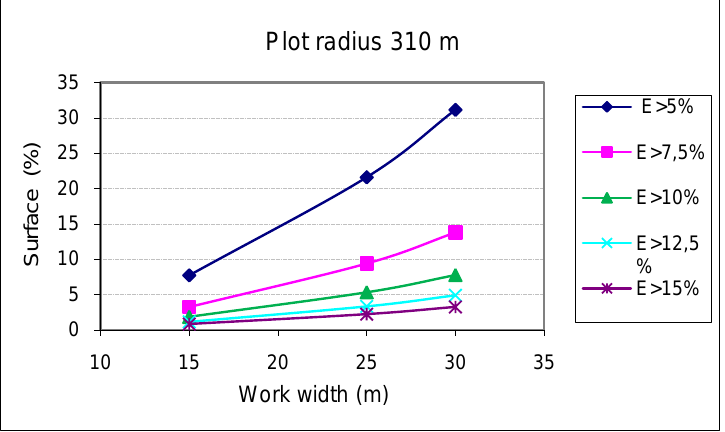
Figure 6. Percentage of surface area with errors (E) in the applied surface dose greater than 5%, 7.5%, 10%, 12.5% and 15% for the case of three sets of equipment with work widths of 15, 25 and 30 m carrying out treatment in circular trajectories in a circular plot with a 310 m-in radius at a displacement velocity of 7 km/h and a nominal nozzle flow of 1.4